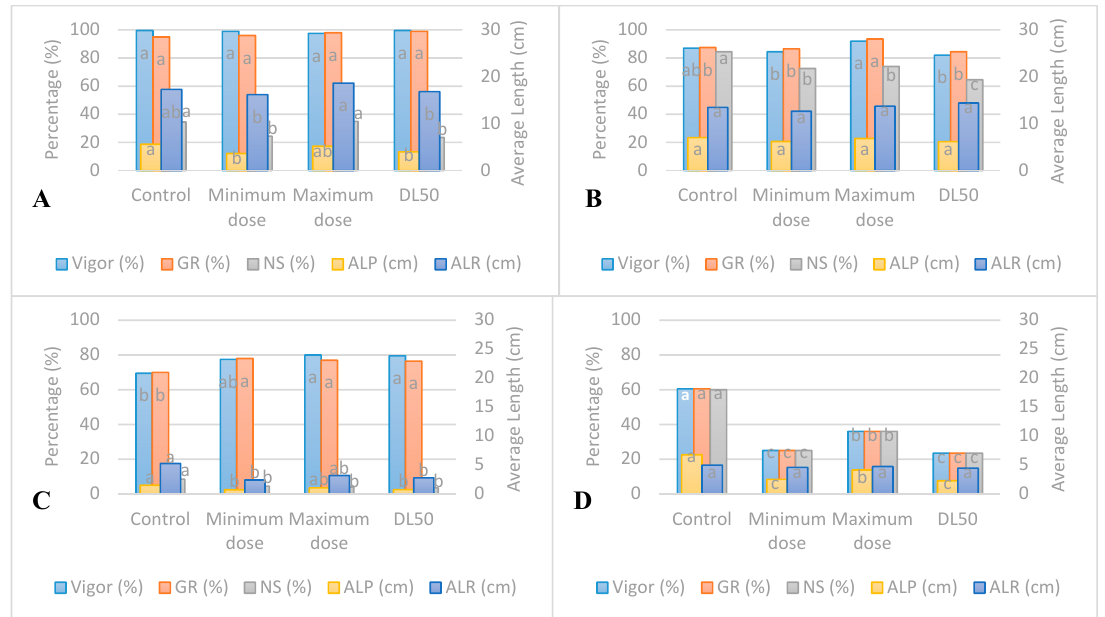
Figure 4. Accelerated aging test in seedlings of four species irradiated with UV-C at different concentrations. A . Glycine Max , B . Triticum aestivum , C . Helianthus annuus , D . Pinus maximartinezii ; GR = germination rate, NS = normal seedlings, ALP = average length of plumule, ALR = average length of radicle. Different letters in columns indicate significant differences ( p < 0.05).